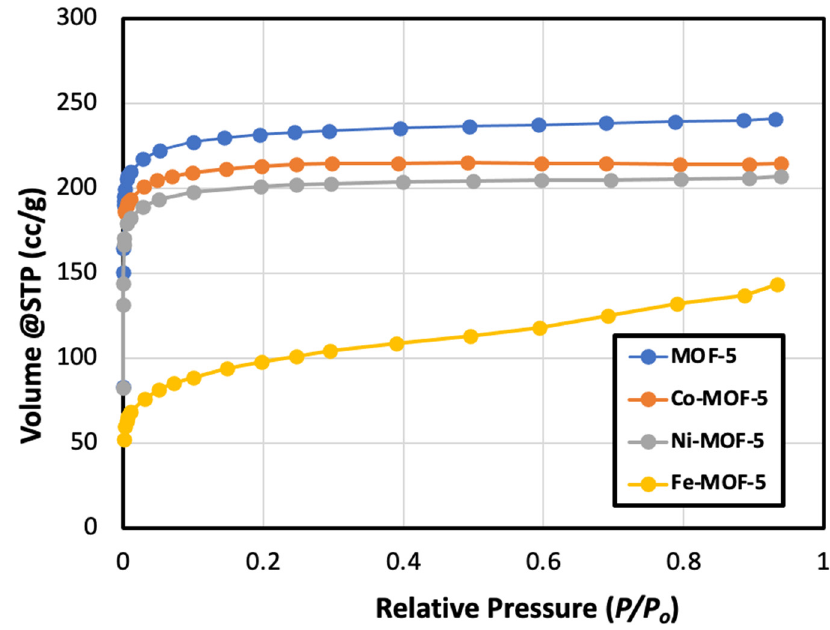
Figure 7. Nitrogen adsorption isotherms at 77K of MOF-5 and M-MOF5. The obtained structural parameters of MOF-5 and M-MOF-5 are shown in Table 1.